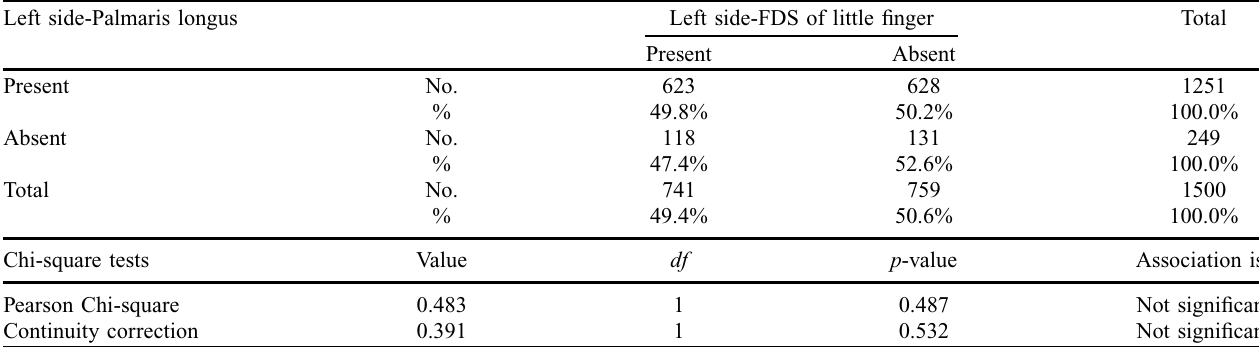
Insignificant association between left side palmaris longus and left side flexor digitorum superficialis* of the little finger. p -value = .487 (>.05). Table 3. Association among the cases between palmaris longus and FDS of little finger when considered bilaterally. Palmaris longus FDS of little finger Present